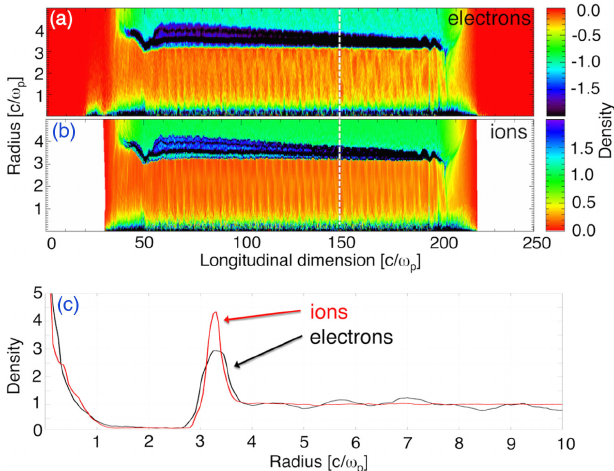
FIG. 2. Electron beam-driven nonlinear ion wake at